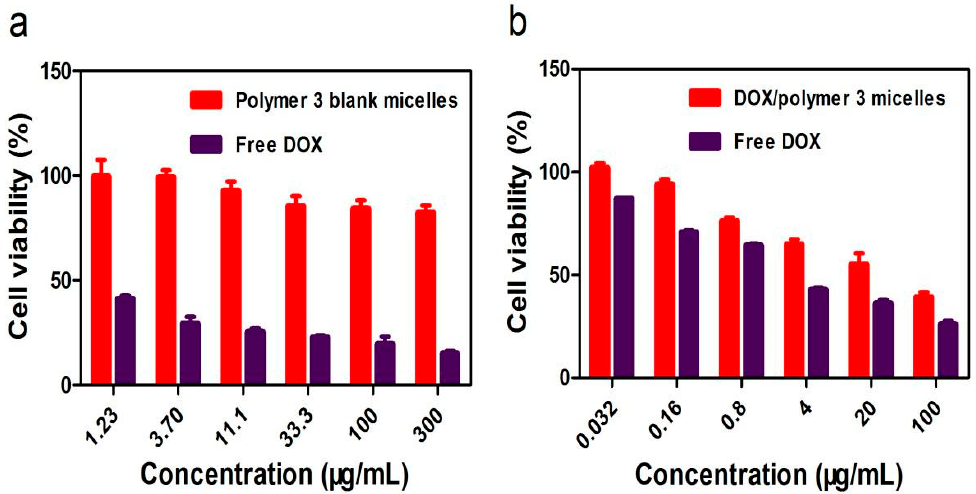
Figure 7. Cytotoxicity of free DOX and polymer 3 micelles in NIH-3T3 cells (a) . Cytotoxicity of free DOX and DOX-loaded polymer 3 micelles in MCF-7 cells (b) .